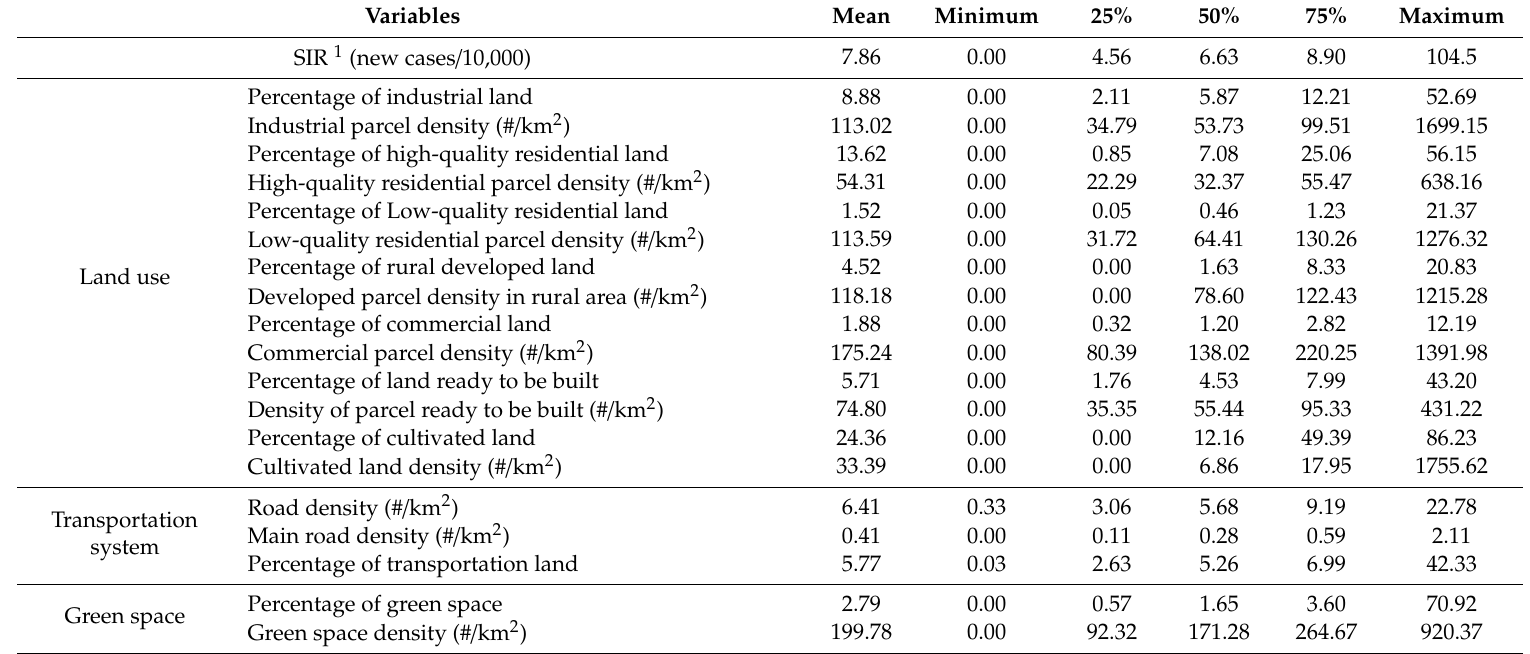
Table 1. Distribution of SIR of lung cancer and built environment